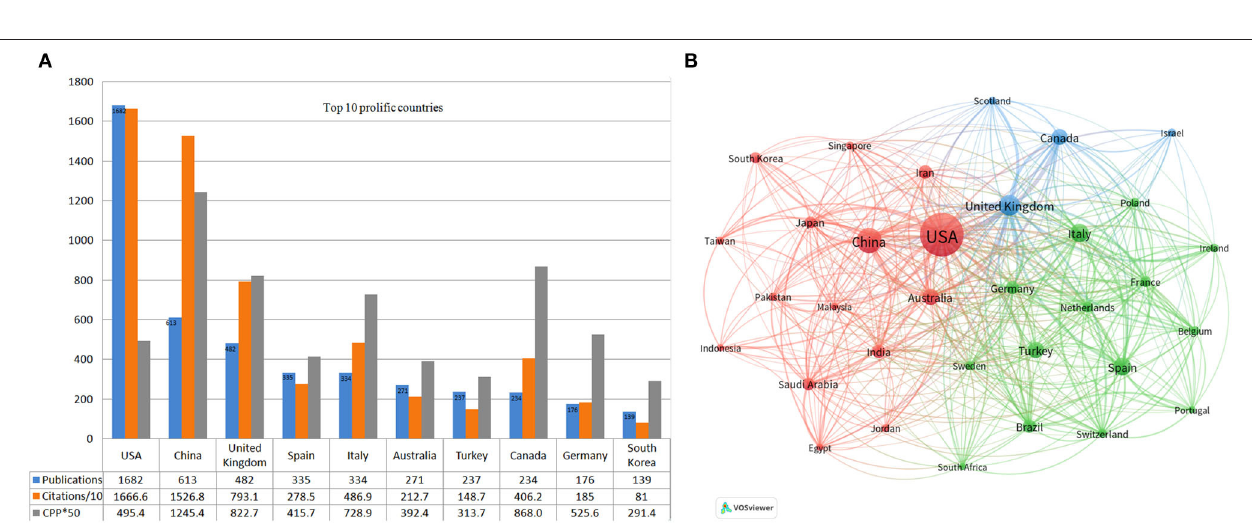
FIGURE 4 | The cooperation network between institutions based on VOSviewer (A) and CiteSpace (B) . Node size indicates the number of publications. The link size refers to the cooperation Intensity.